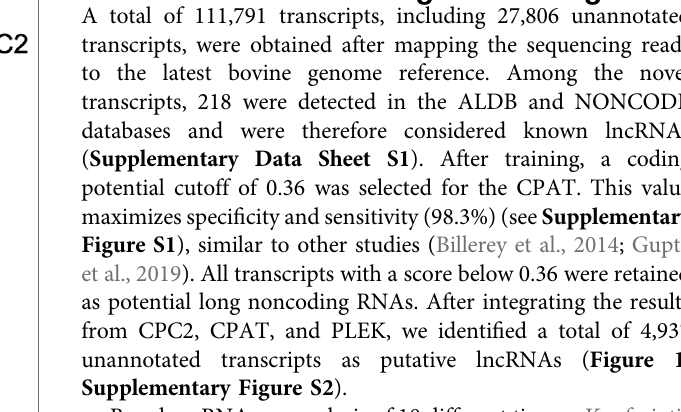
Supplementary Table S2 . Real-time PCRs were performed